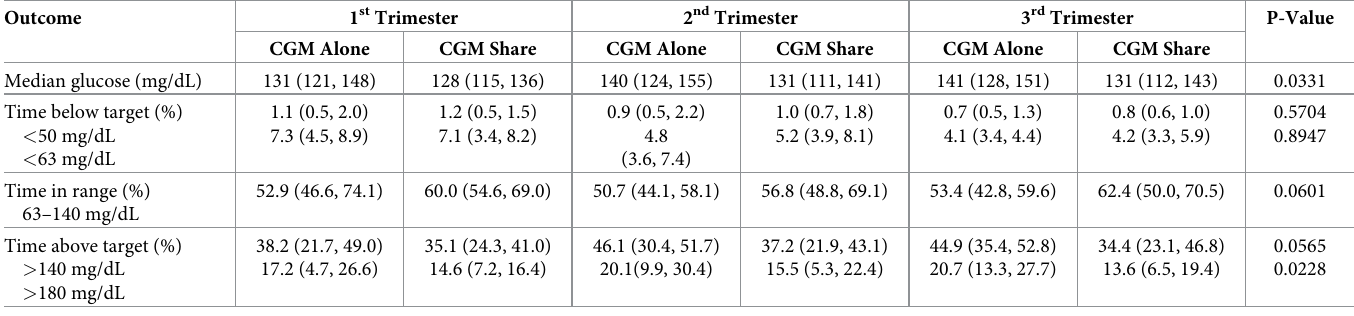
Table 2. Maternal CGM measures a